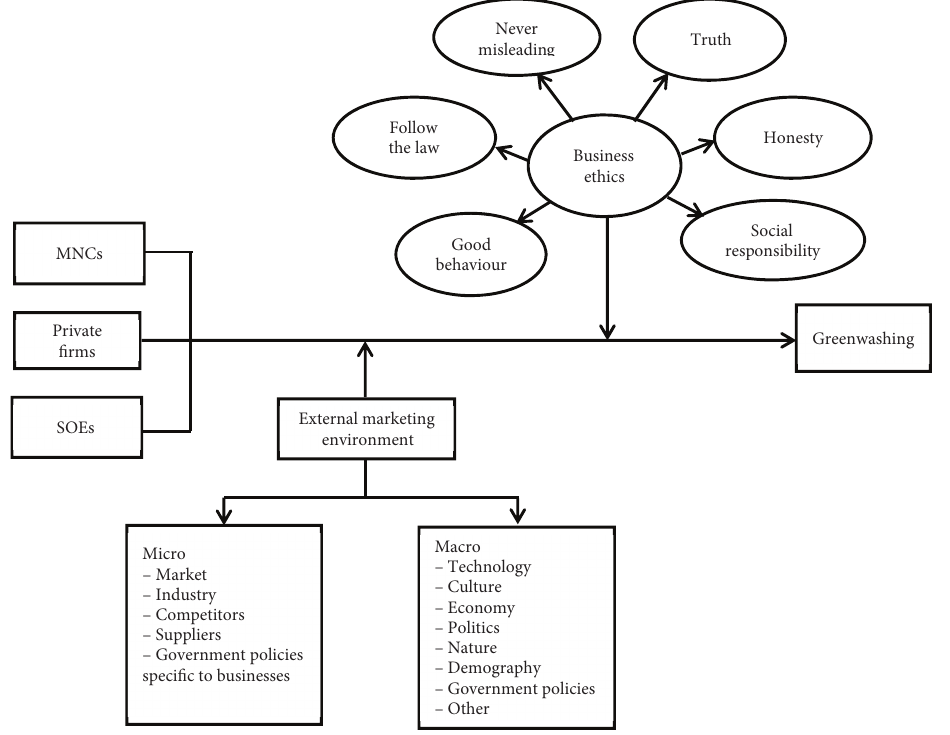
Figure 3. The sources of